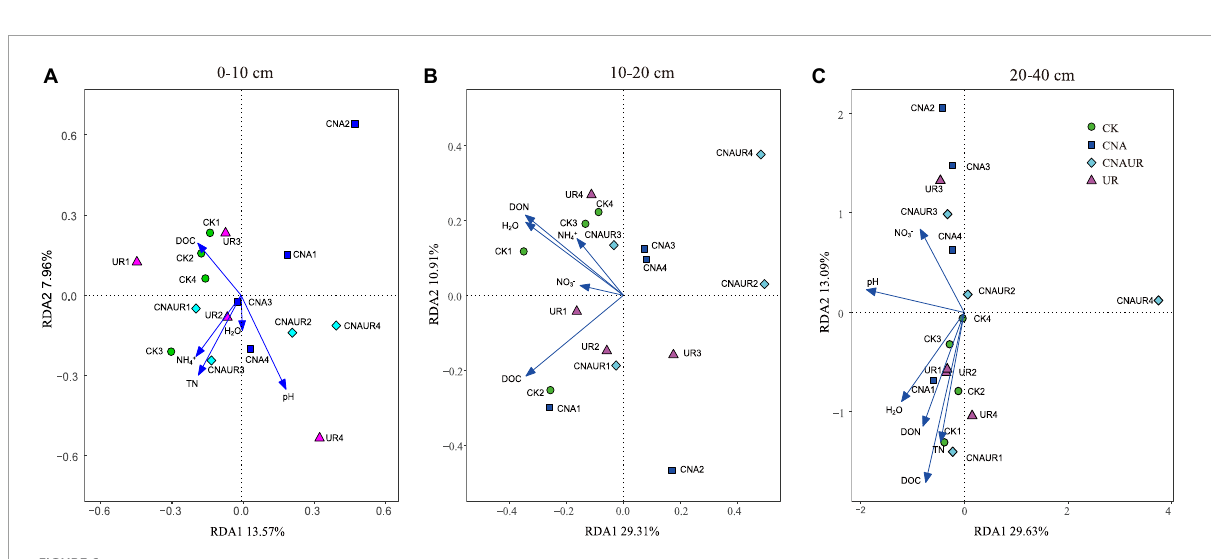
found between the relative abundances of Mortierellales and unclassified taxa of the phylum Archaeorhizomycetes and NO 3 − and between the relative abundance of Venturiales and TOC. In the 20–40 cm layer, however, the relative abundances of Agaricales and Thelephorales were positively